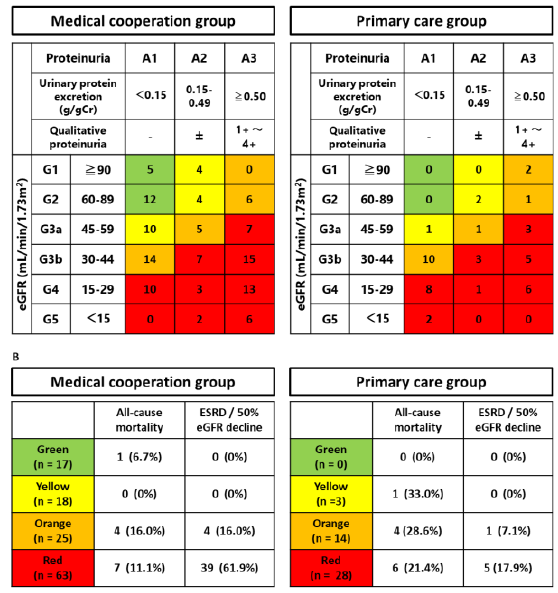
Figure 2. The association between CKD stage and medical cooperation. ( A ) The CKD stages of the participants are shown by the group as KDIGO 2012 heatmap at baseline. ( B ) The incidence of the outcomes is shown by KDIGO 2012 heatmap. Table 1. Characteristics of the study population.